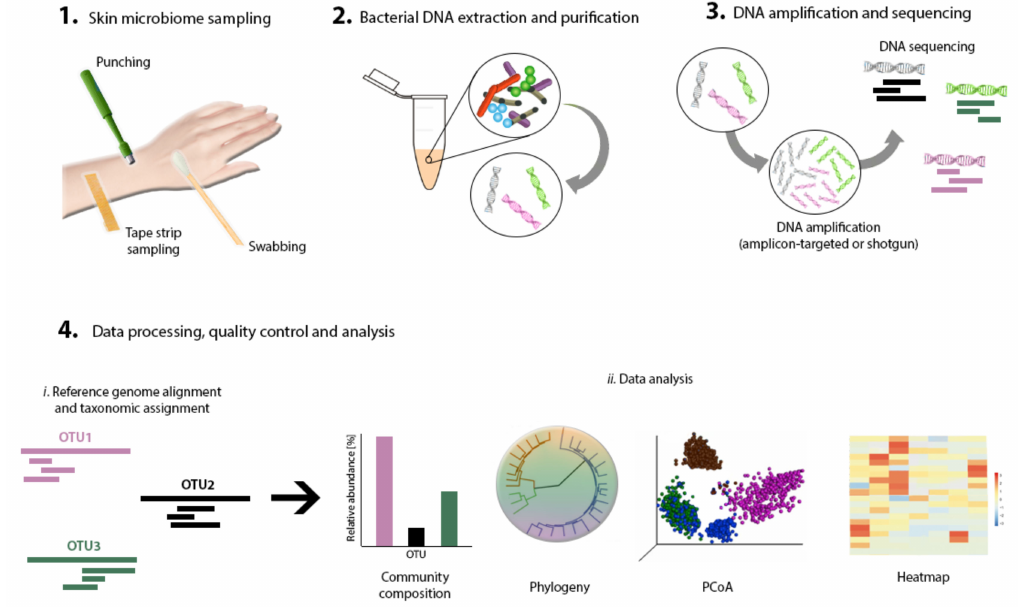
Figure 2. Skin microbiome research workflow. Primary steps include skin sampling, bacterial DNA extraction, purification, amplification and sequencing, data processing, and